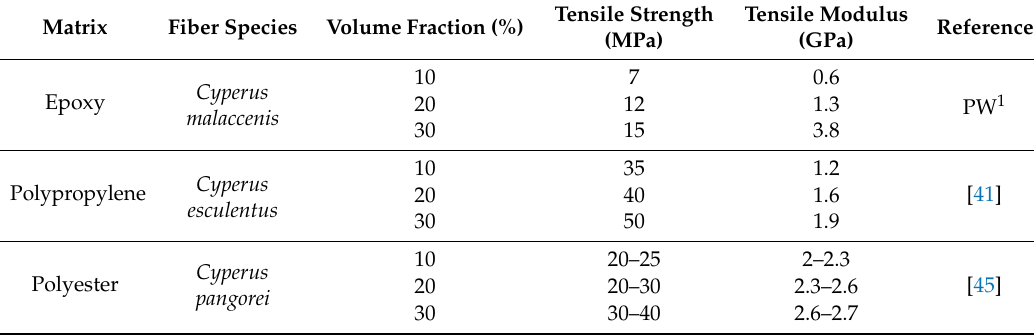
Table 9. Tensile strength and elastic modulus comparison of composites reinforced with di ff erent natural fibers belonging to the Cyperus